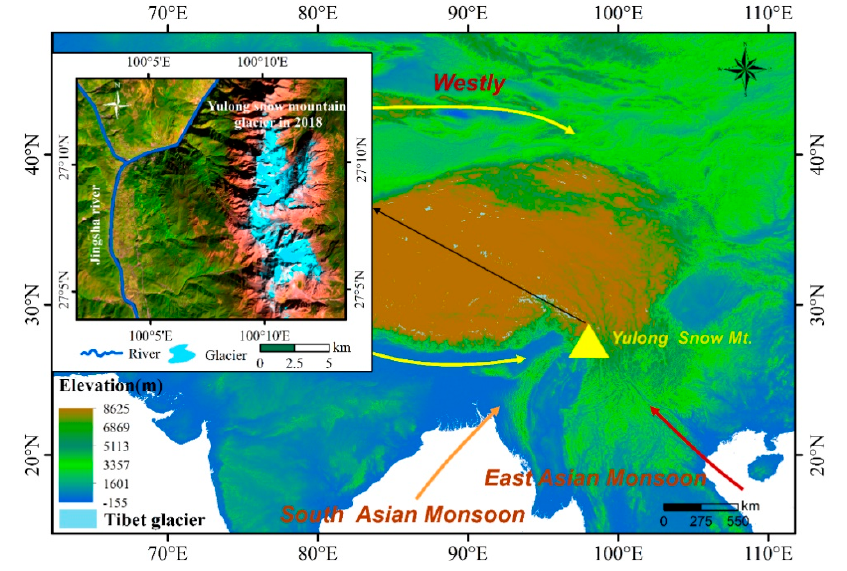
Figure 1. The geographical location and glacier distribution of Mt. Yulong.